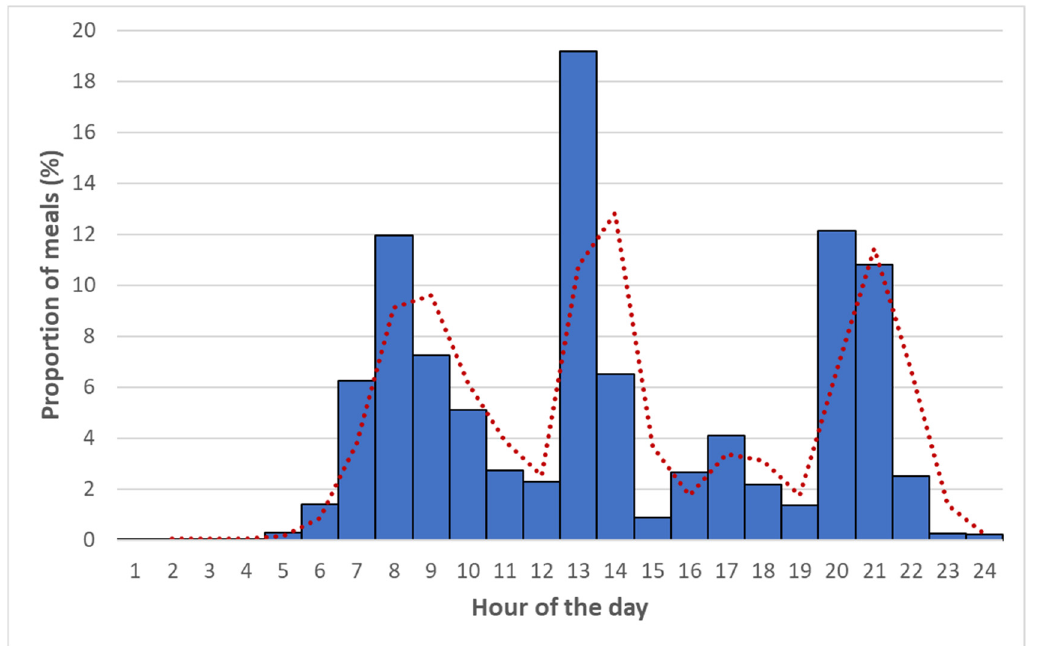
Figure 1. Proportion of meals consumed over the day. Bars represent the percentages of meals occurring at each hour of the day. Percentages are obtained by dividing the number of meals in each hour of the day by the total of all meals recorded. Red line represents the moving average line of the proportion of meals over the day.